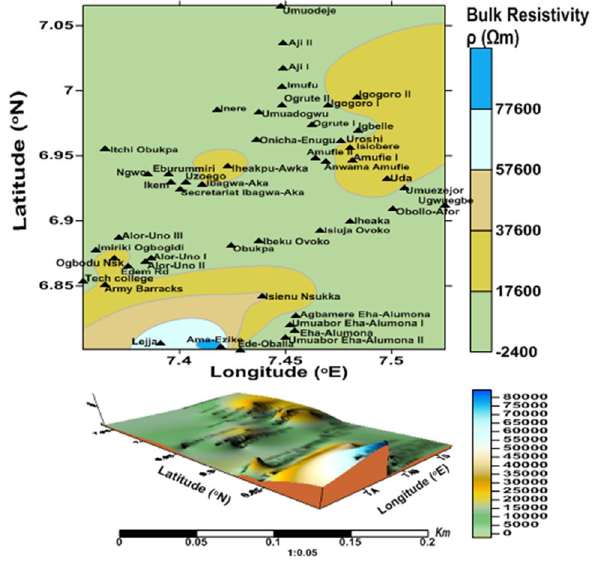
Fig. 5 2D and 3D contour map showing the variation of bulk resistiv- ity in the study area